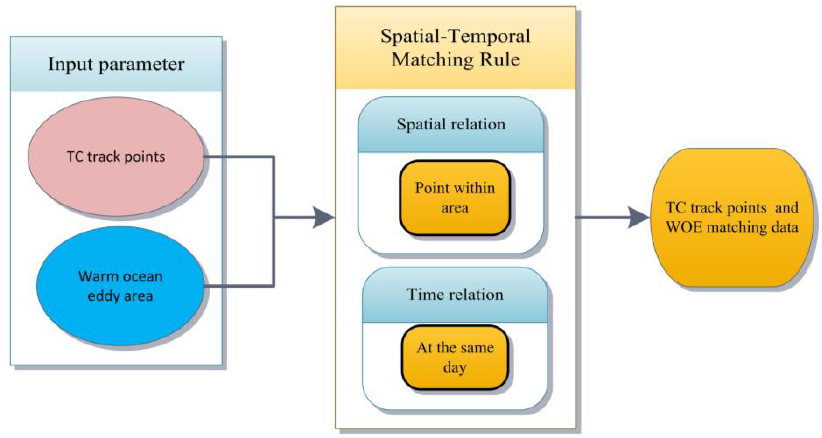
Figure 1. A flowchart showing how the interacting tropical cyclones (TCs) and warm ocean eddies were selected in this study.